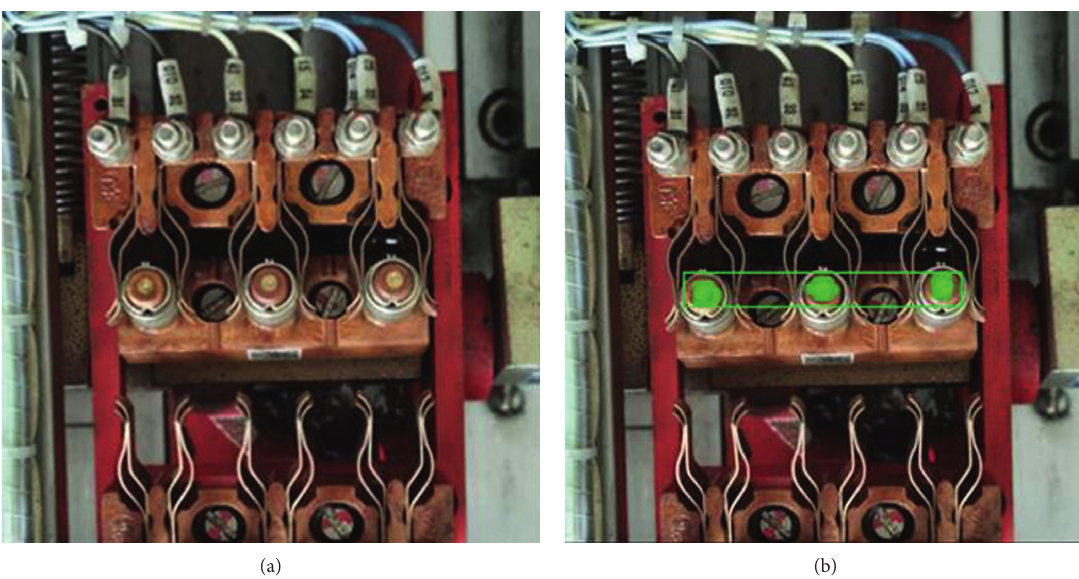
Figure 9: The comparison of detection result: (a) the original image; (b) the rough positioning image.